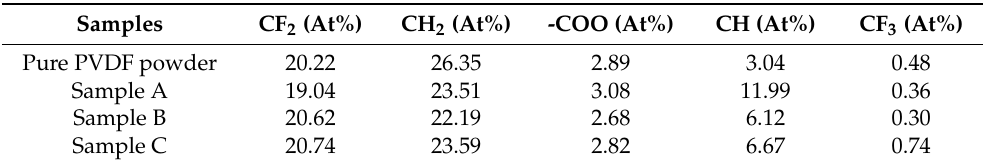
Table 2. Atomic percentage of C 1s surface chemical composition of the pristine PVDF powder and the as-prepared fiber samples.